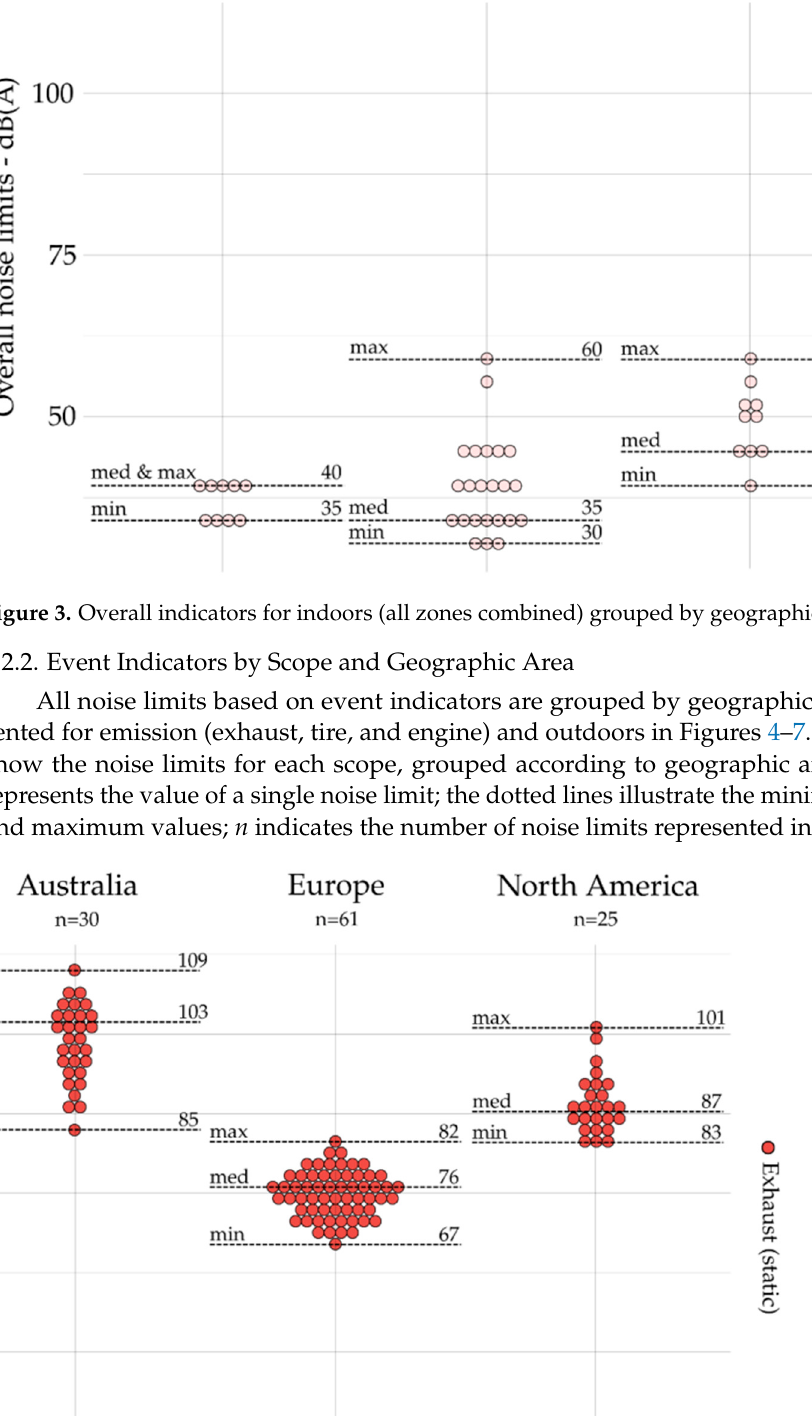
Figure 5. Event indicators for emission (i.e., tire) and grouped by geographic area ( n = 21).